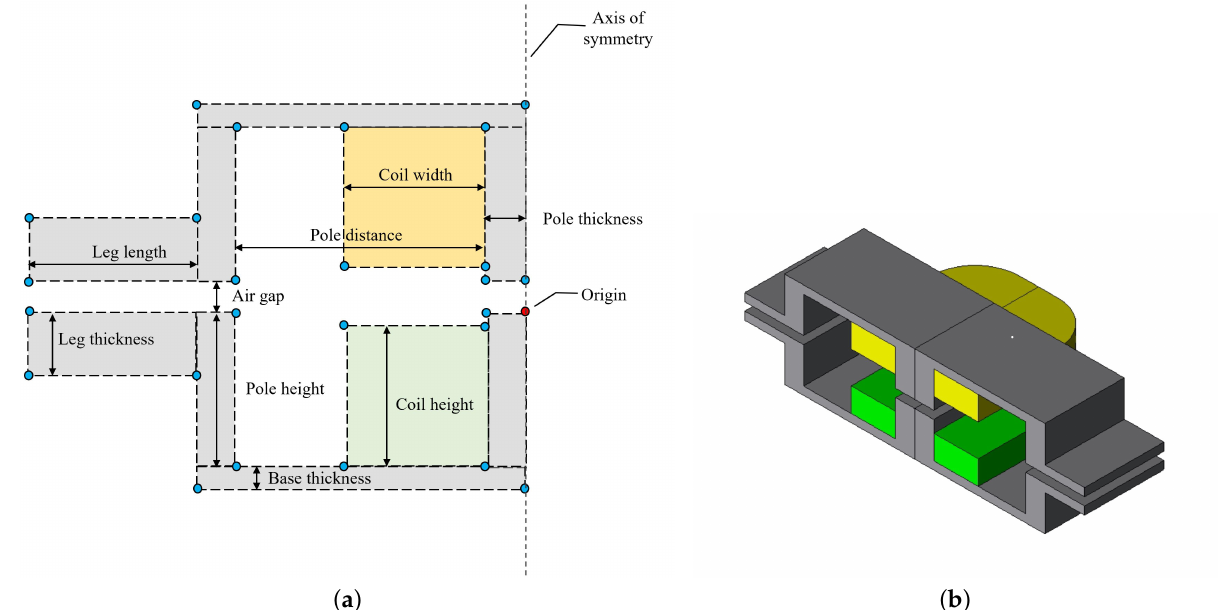
Figure 2. Configuration of CIPT device structured as EE shape with legs. ( a ) is the parts division in 2D and ( b ) is a sectioned 3D image from the cross-section.